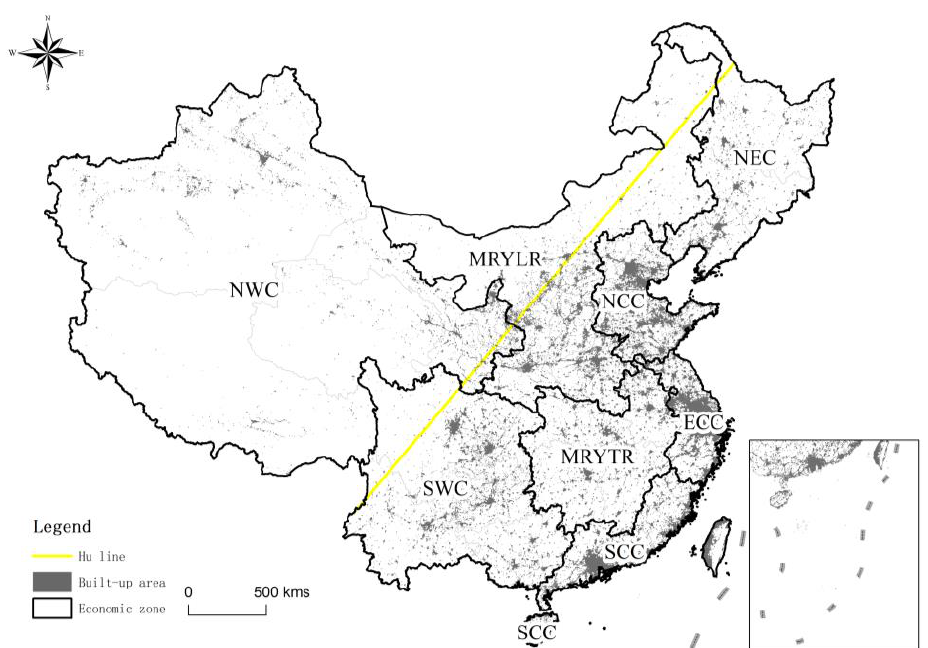
Figure 2. Built-up area of China extracted by VIIRS. (The Hu line in Figure 1 extending from Aihui in the Heilongjiang Province to Tengchong in the Yunnan Province is a demographic demarcation. The southeast, with 36% of the country’s area, contains 96% of the Chinese population, while the northwest, with 64% of the total area, contains only 4% [55]. The ratios of populations of the two areas have not changed much despite changes in the national territory and massive urban migration in recent years).